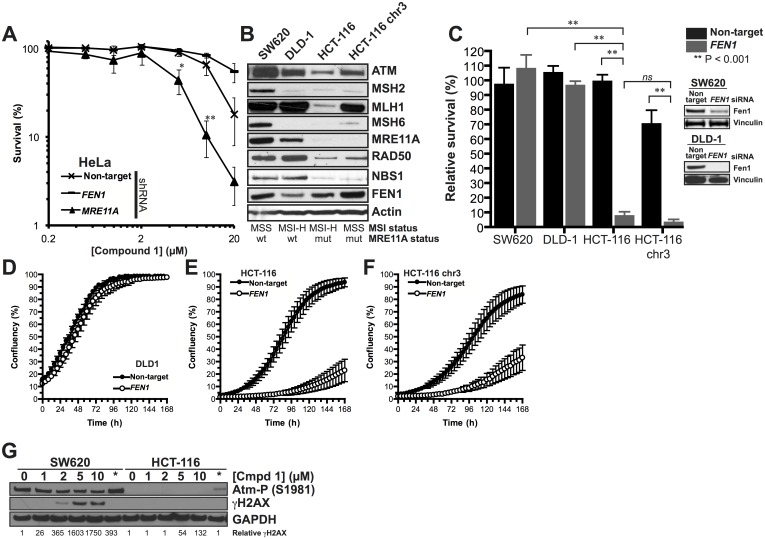
Sensitivity of MSI cell-lines to FEN1 inhibition is through MRE11A deficiency.A. Cells down-regulated for MRE11A by shRNA are sensitive to FEN1 inhibitor 1. B. Confirmation that the MSI cell-line HCT-116 is disrupted for the MRN complex. Re-introduction of chromosome 3 (HCT-116 chr3) restores MLH1 without affecting MRE11A protein level. C-F. Down-regulation of FEN1 by siRNA is toxic in MSI cells devoid of MRN complex by clonogenic survival (C) or by measuring proliferation (D-F). Each data point is the mean of at least 3 individual repeats and the error bars represent the standard error. Significance was determined by student t-test. ns = not significant * p < 0.05. ** p < 0.005 G. HCT-116 cells fail to signal for the DNA damage response upon treatment with 1.